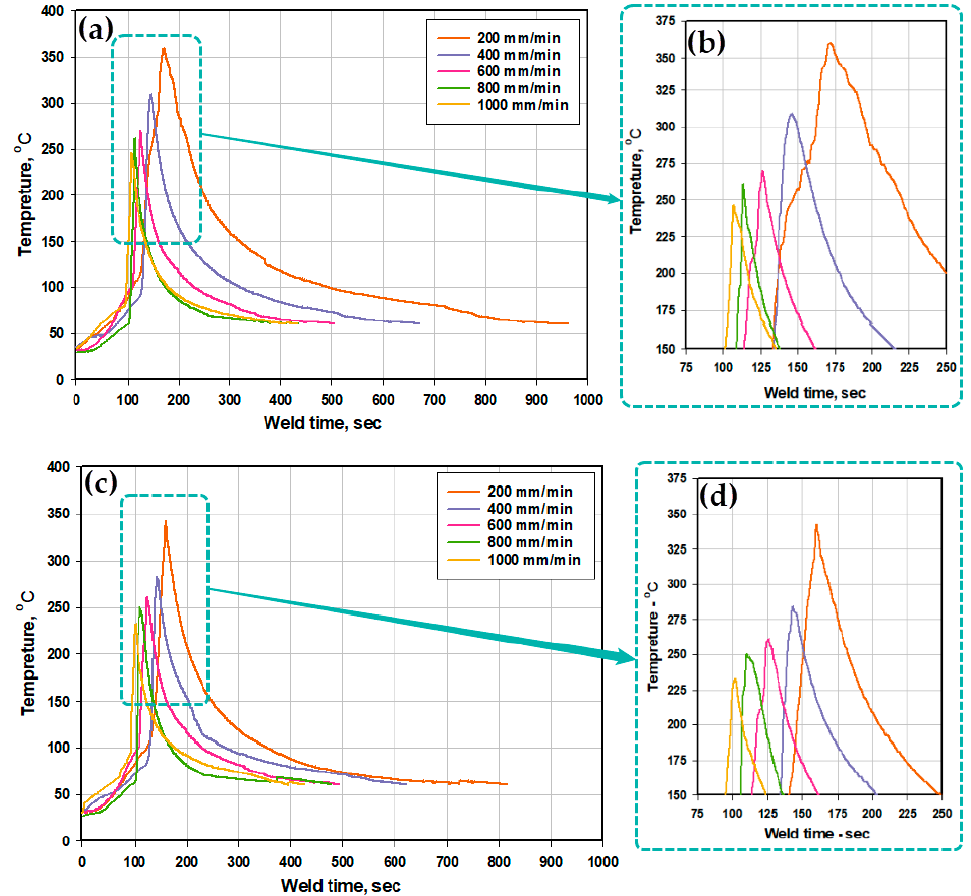
Figure 7. An example of the recorded temperature profiles obtained with the embedded thermo- couples during BT-FSW of aluminum using the Sq pin using a constant rotation speed of 600 rpm at ( a and b ) advancing side and ( c and d ) retreating side.